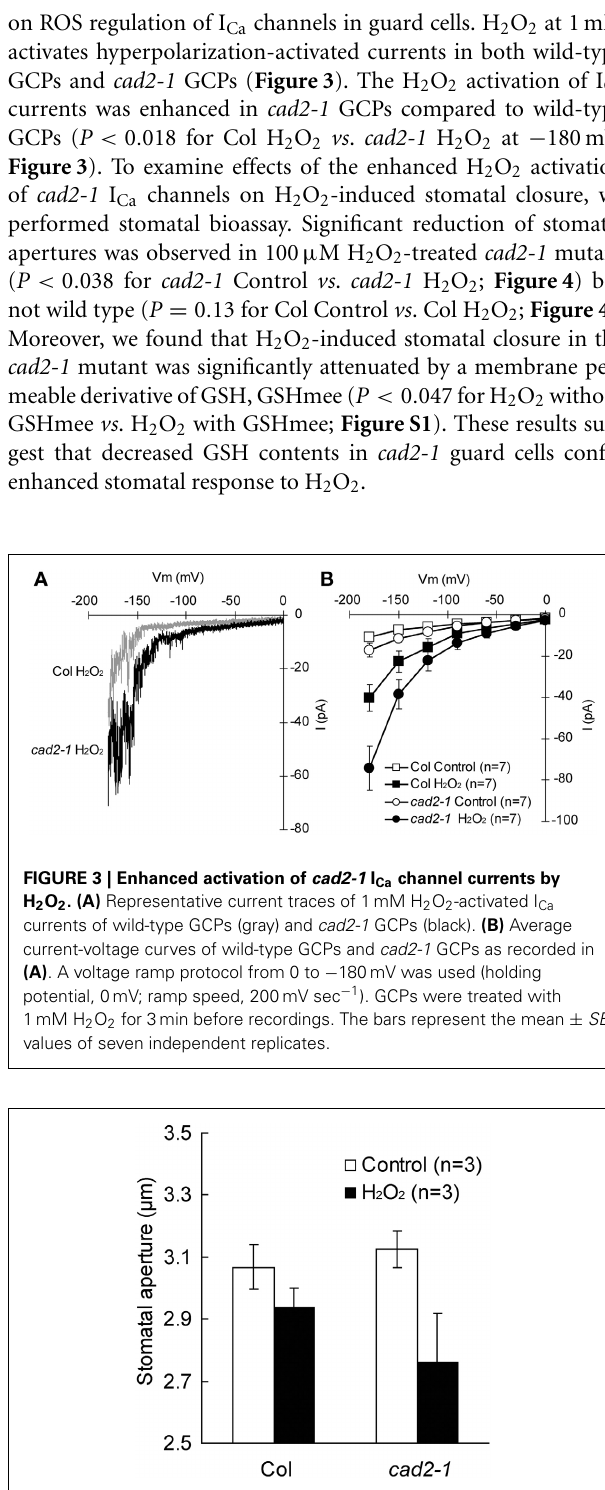
FIGURE 4 | Stomata of the cad2-1 mutant are more sensitive to exogenous H 2 O 2 than those of wild type. Stomatal apertures of wild type and the cad2-1 mutant were measured 2h after 100 μ M H 2 O 2 application. Twenty averages from three independent experiments (60 total stomata per bar) are shown. The bars represent the mean ± SE